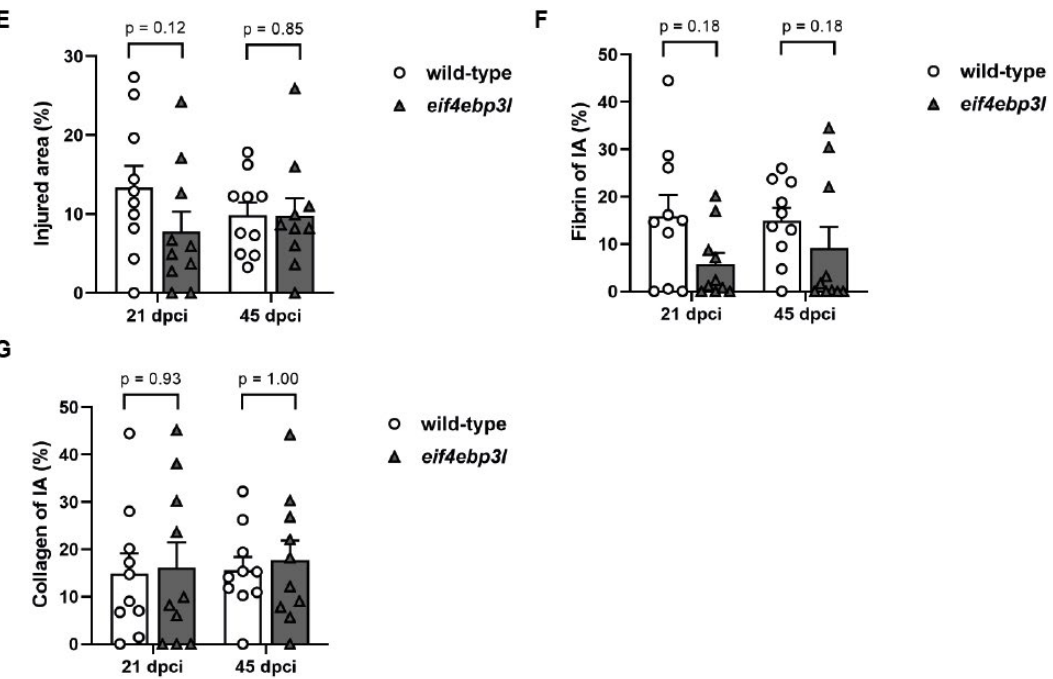
Figure 5. Effects of eif4ebp3l overexpression on scar formation after cryoinjury. ( A – D’ ) Acid fuchsin orange G (AFOG) staining of wild-type Tg(fli1:eGFP) and Tg(fli1:eGFP/hsp70l:eif4ebp3l-p2A-tdTomato) zebrafish hearts at 21 dpci and 45 dpci. Intact myocardium is stained in orange, fibrin in red and collagen in blue. The injured area (IA) is marked by the red box. ( A’ – D’ ) Magnified view of the IA. ( E – G ) Quantification of the IA and its composition. Values are mean ± SEM, n = 10 per group and day post cryoinjury. Scale bar = 100 µm.